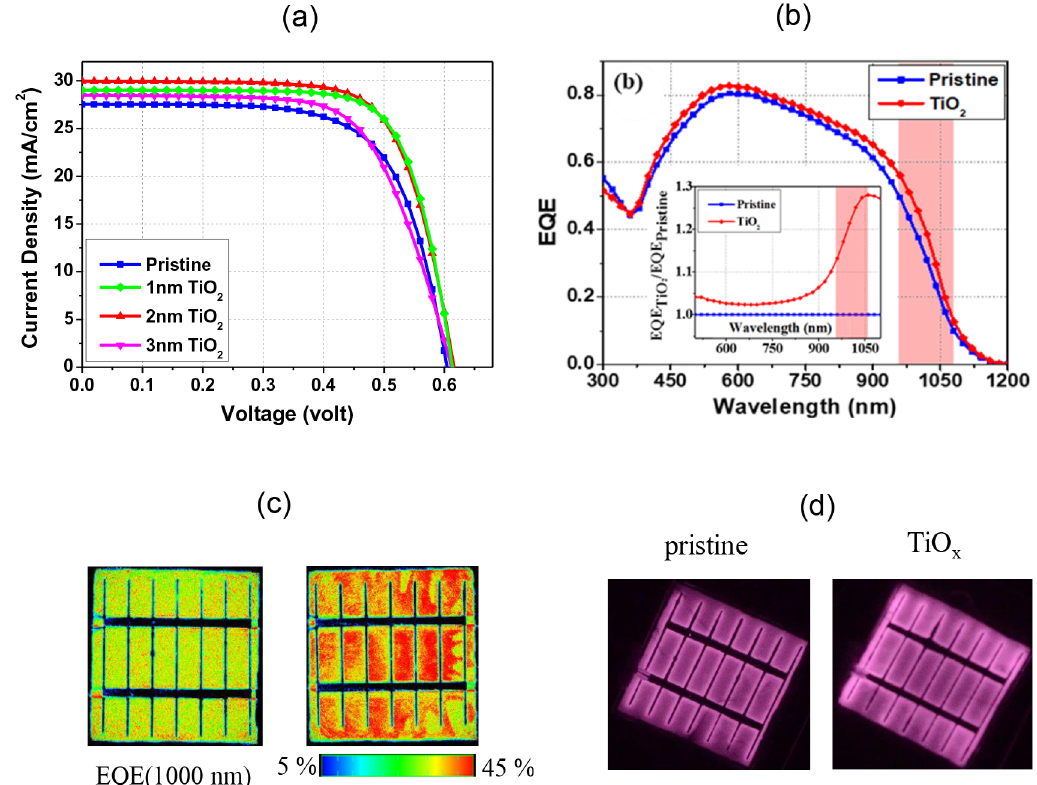
Fig. 4. (a) J – V curve of PEDOT:PSS/n-Si solar cells TiO 2 HBLs with different layer thicknesses. (b) EQE for devices with and without a 2-nm-thick TiO 2 HBLs. The inset shows EQE TiO2 /EQE pristine . (c) 2D map of EQE at 1000nm and (d) far-infrared EL emission images for devices with and without a 2-nm-thick TiO 2